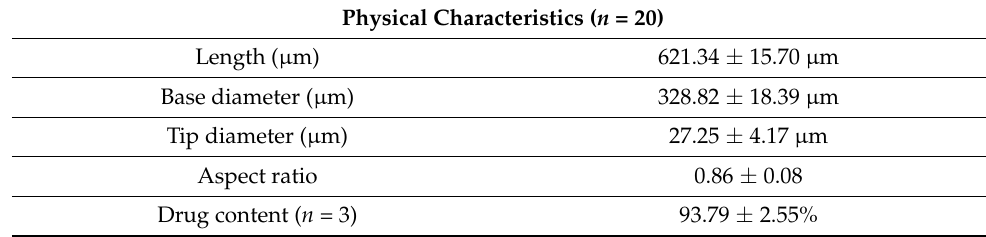
Table 3. Physical characteristics of the CUBs- MN D